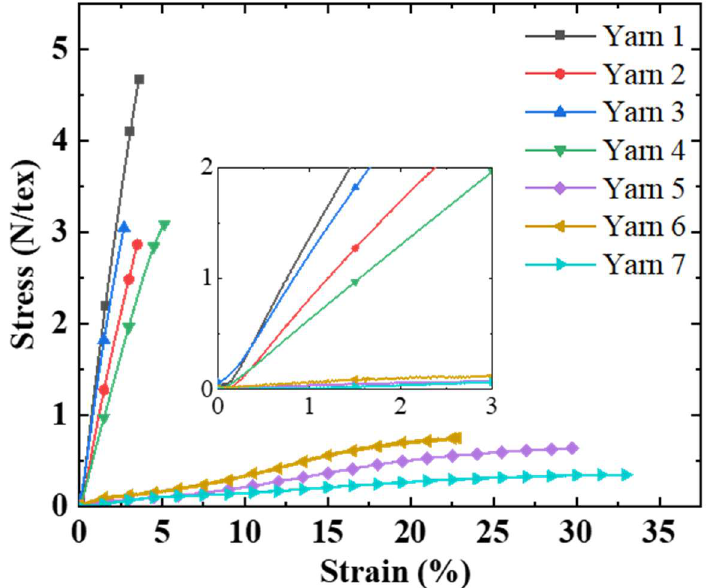
Figure 2. Classic stress–strain curves of used yarns. The inset figure shows the results below 3% strain.